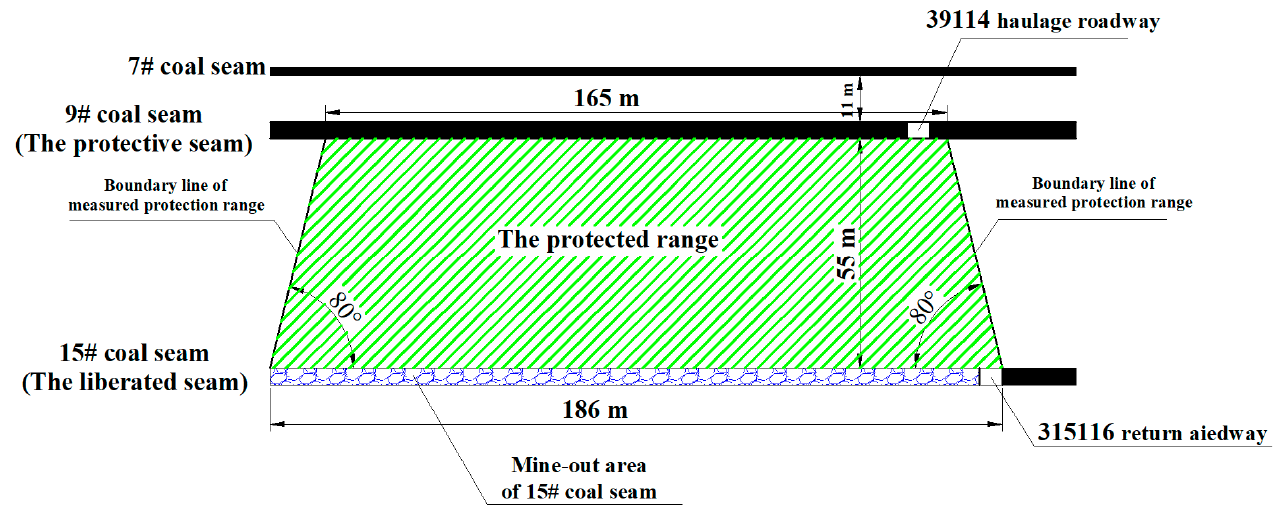
Figure 3. Positional relationship and protected range of the liberated and protective seams.